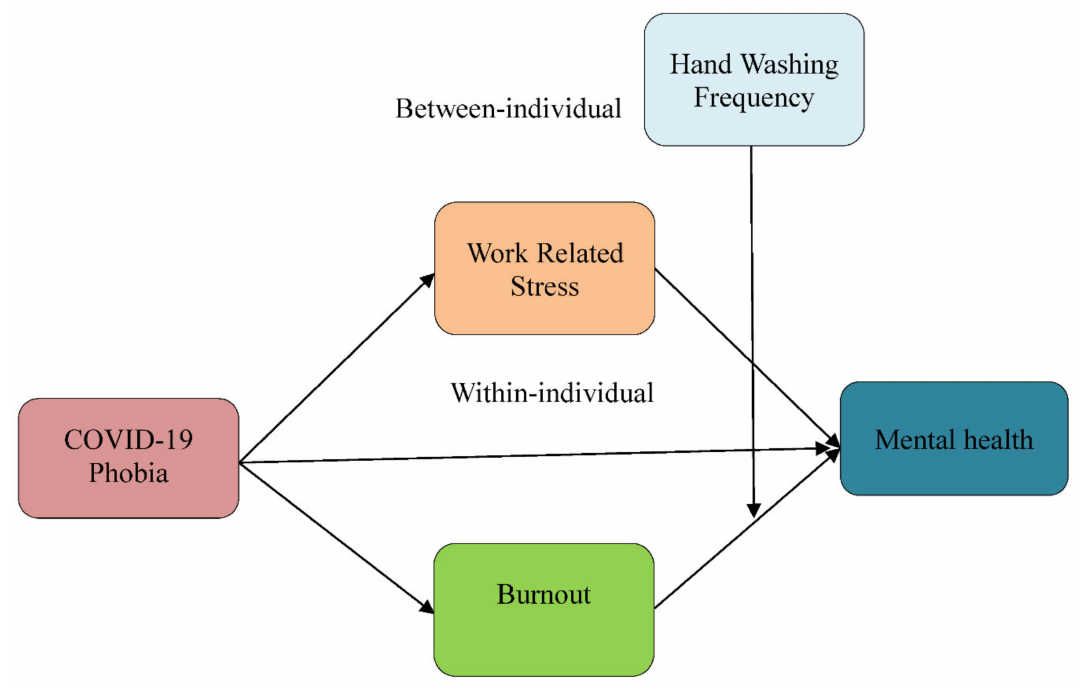
Figure 1. Research